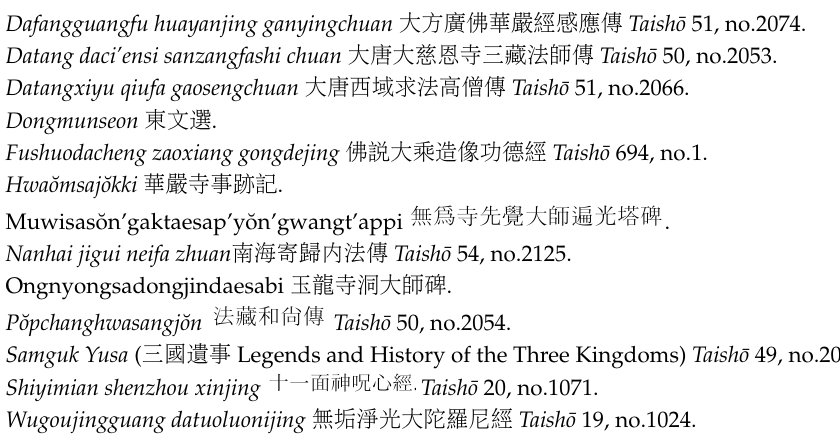
Figure 20. Clay Buddha, Pagan period, 12th–13th centuries, 9.6 × 7.1 cm, Myanmar [Source: (Fukuoka Art Museum 2008, cover picture)].